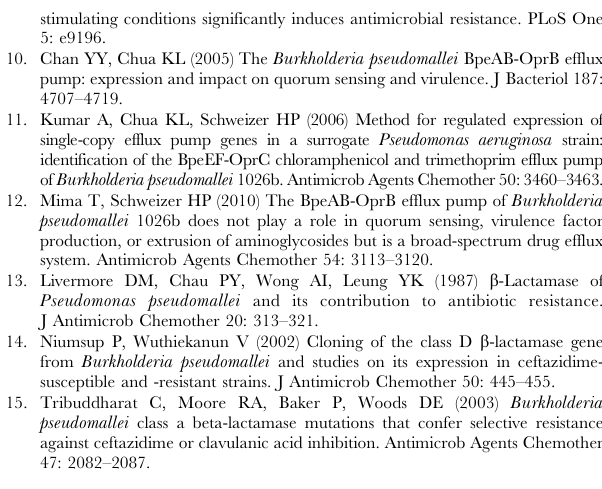
Figure S1 Functional categorization of B. pseudomallei essential genes. (TIF) Figure S2 Effect of valinomycin on the PMF as estimated fluorometrically by measuring the accumulation of DiSC 3 (5). Table S1 List of B. pseudomallei essential